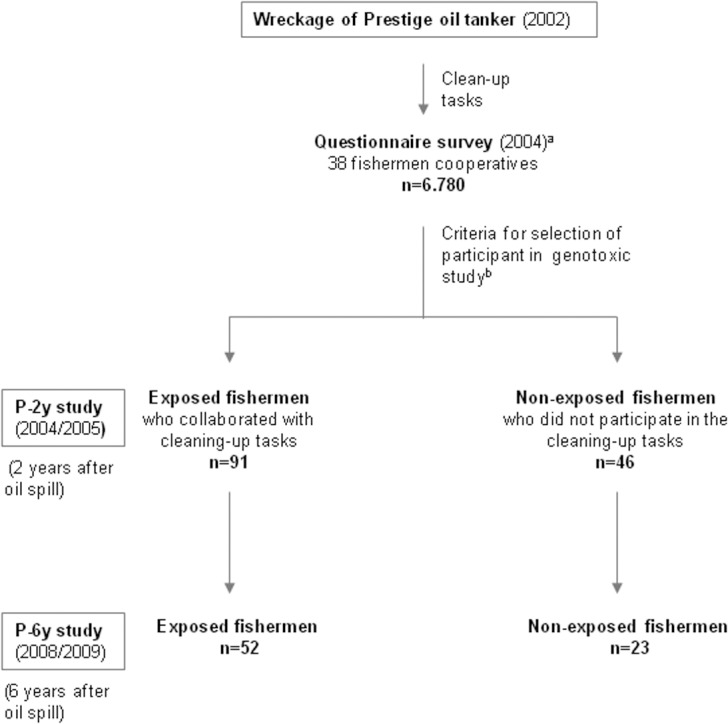
Flow diagram of the study.
aDetailed description in Zock et al. 2007. bDetailed description in Rodriguez-Trigo et al. 2010.